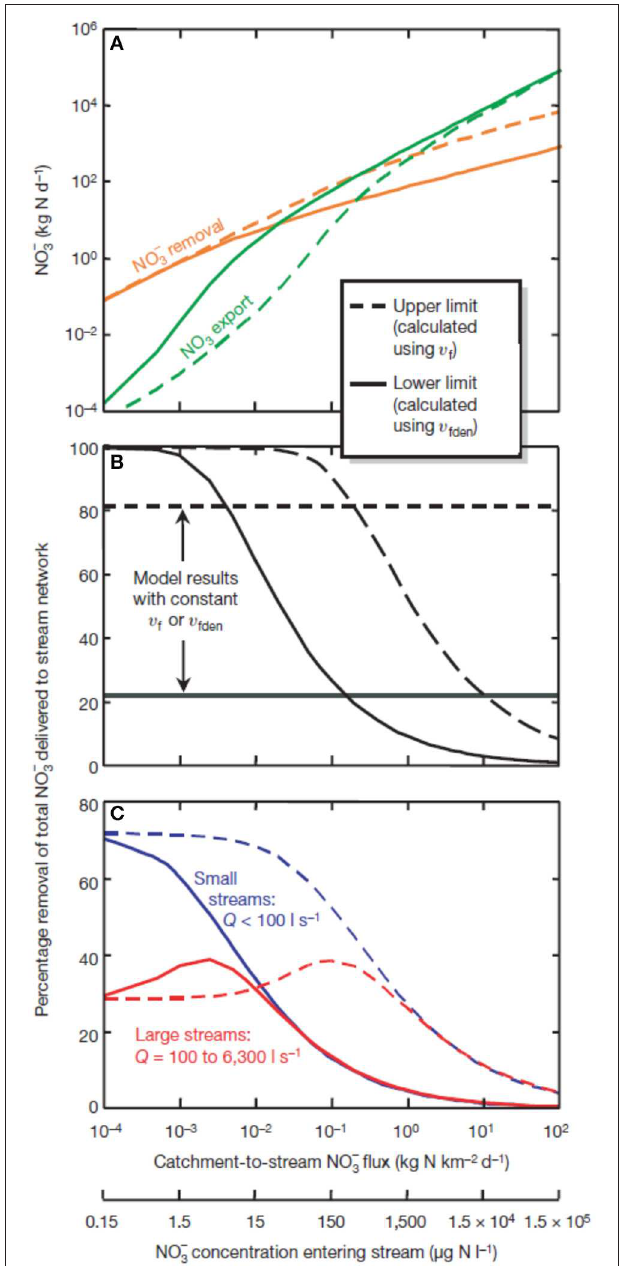
FIGURE 2 | Modeled data from the LINX II project showing (A) the relationship between removal and export of NO − 3 against NO − 3 loading rates (as both catchment to stream flux and as stream water concentration); (B) NO − 3 removal due to biological processes with curves reflecting model results when uptake velocity (V f ) and uptake velocity due to denitrification (V fden ) vary with NO − 3 concentrations; (C) patterns of NO − 3 removal shown for small and large streams [curves similar to those shown in (B) ]. See Mulholland et al. (2008) for additional